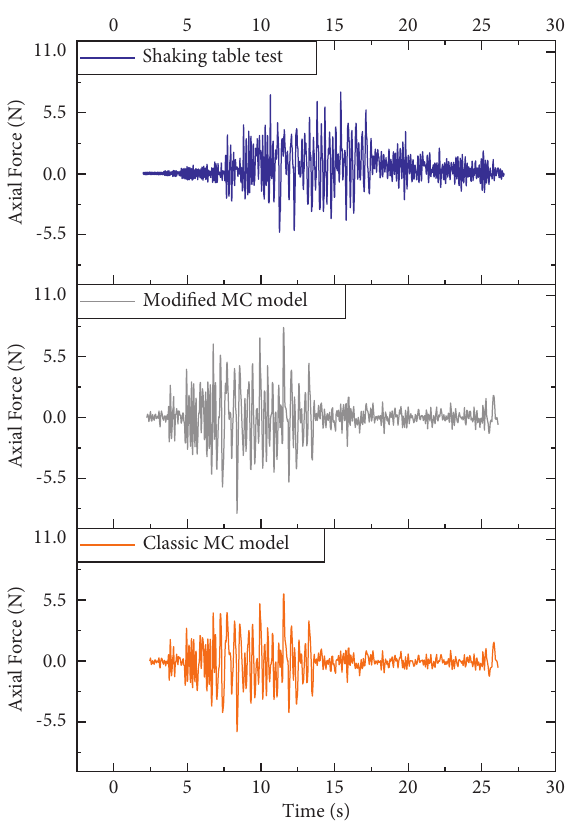
Figure 27: : Axial force time history of section 2 arch